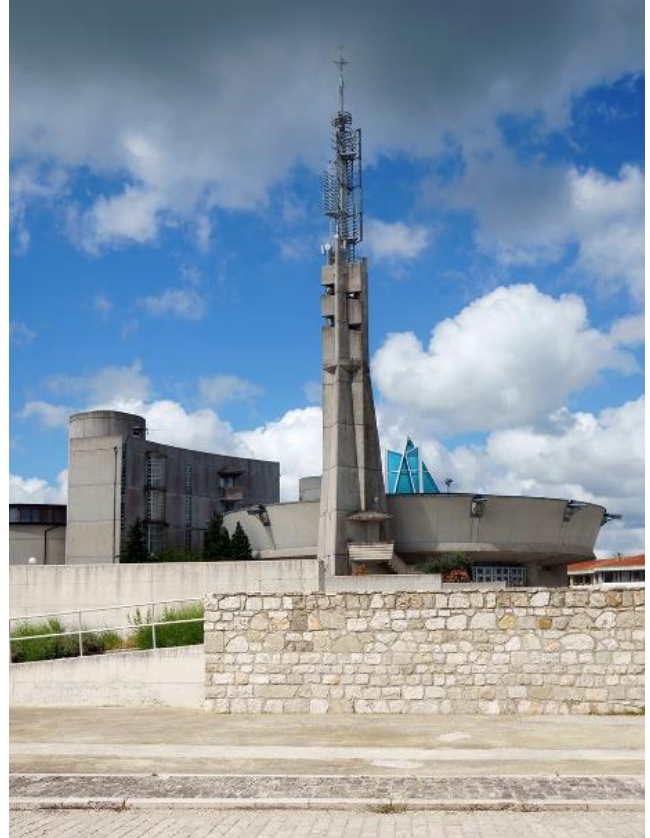
Figure 105. Bisaccia: the new village (Piano di Zona) with new Church of Sacro Cuore built by the architect A. L. Rossi, 1998 (photos by